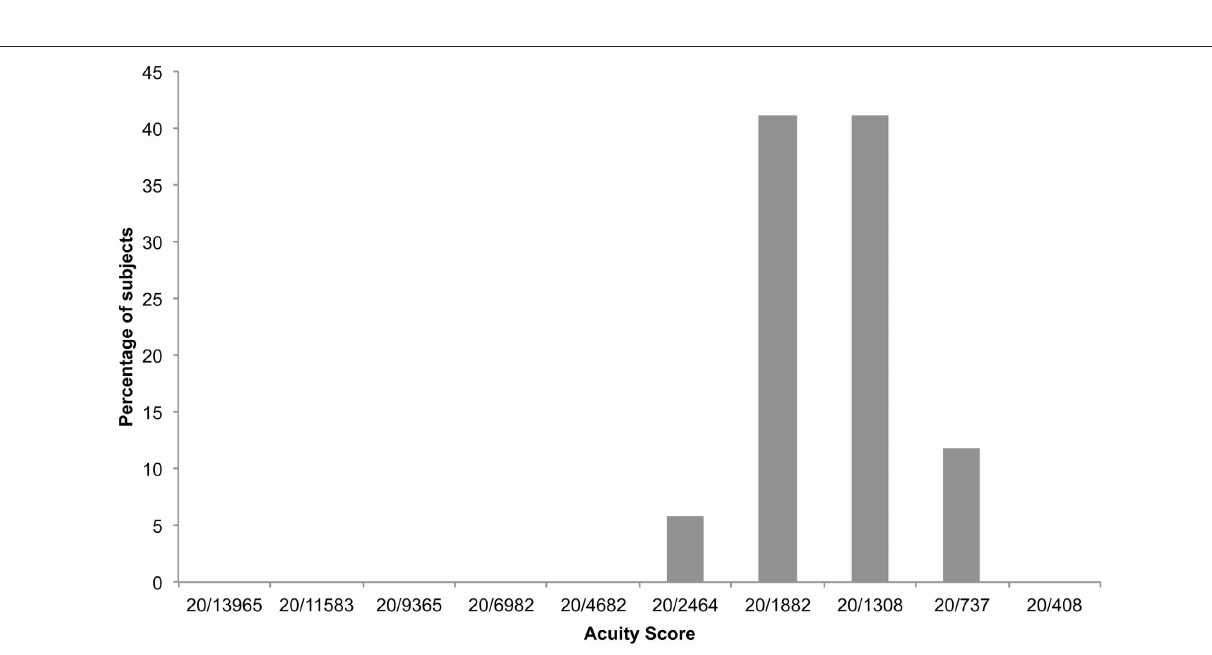
scores between 20/2464 and 20/737. Scores of 20/1882 and 20/1308 were achieved by the highest number of participants ( Figure 5 ). Median acuity was 20/1308 Participants collec- tively were significantly above the threshold of 8/12 correct responses up to 20/2464 and above chance (4/12) up to 20/737 ( Figure 6 ).